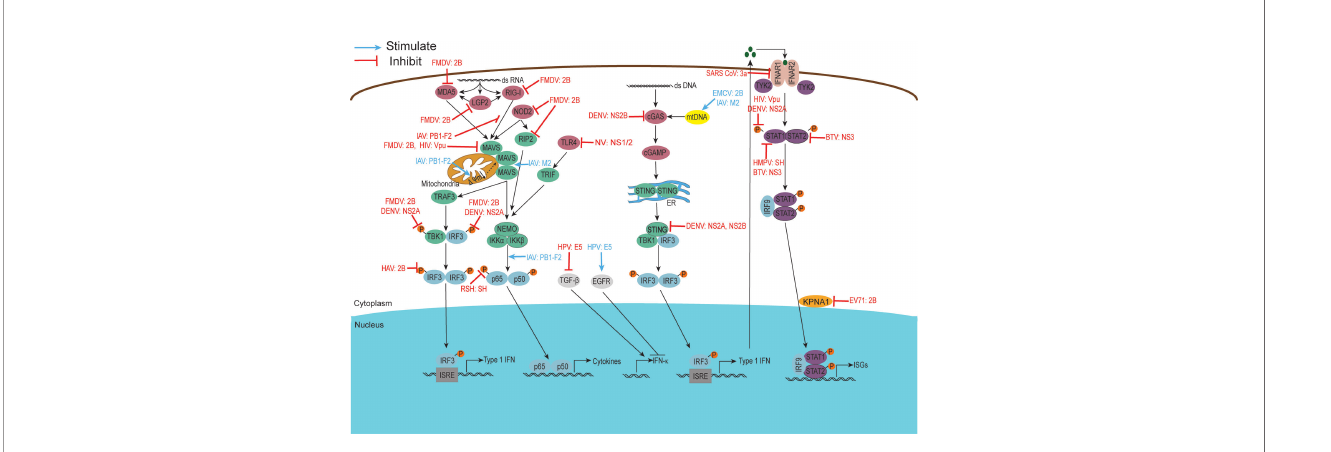
FIGURE 6 | Viroporins regulate host immune responses. viroporins modulate host cell immune responses by interfering with PRRs recognition, interfering with bridging molecules, kinases, and downstream effectors in the innate immune signaling pathway, and interfering with IFN-mediated signaling. Figure adapted from